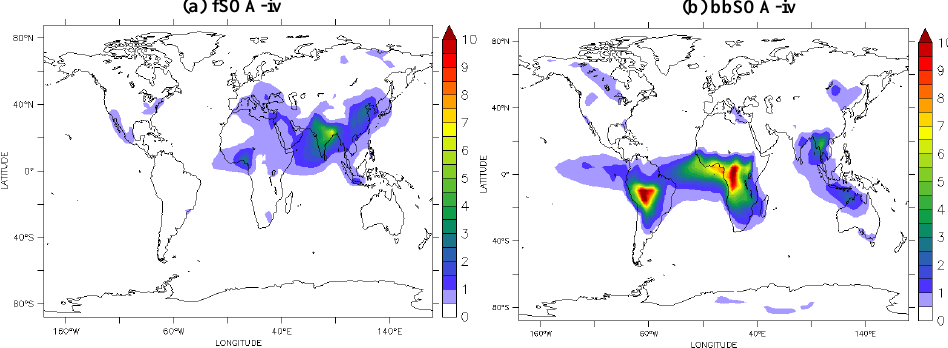
Figure 6. Modeled average surface concentrations (in µgm − 3 ) of (a) SOA-sv from the oxidation of SVOCs from fuel combustion (fSOA-sv) Figure 6: Modeled average surface concentrations (in μg m -3 ) of (a) SOA-sv from the oxidation and (b) SOA-sv from the oxidation SVOCs from biomass burning emissions (bbSOA-sv) during the years 2005–2009. of SVOCs from fuel combustion (fSOA-sv) and (b) SOA-sv from the oxidation SVOCs from 1242 biomass burning emissions (bbSOA-sv) during the years 2005-2009. 1243